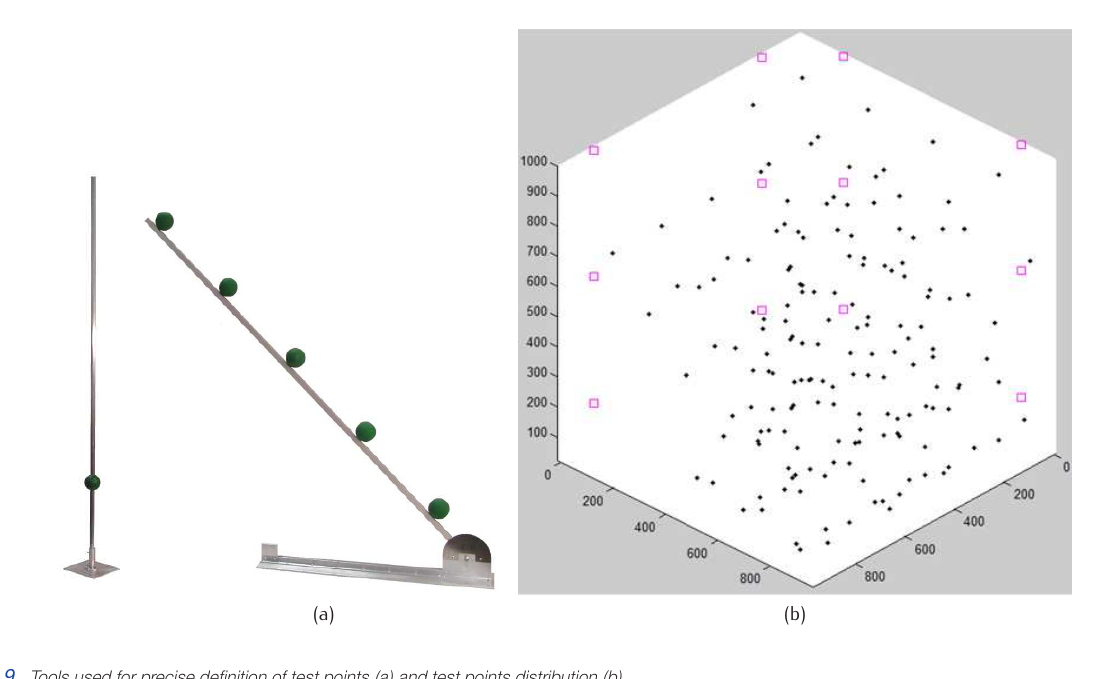
Figure 9. Tools used for precise definition of test points (a) and test points distribution